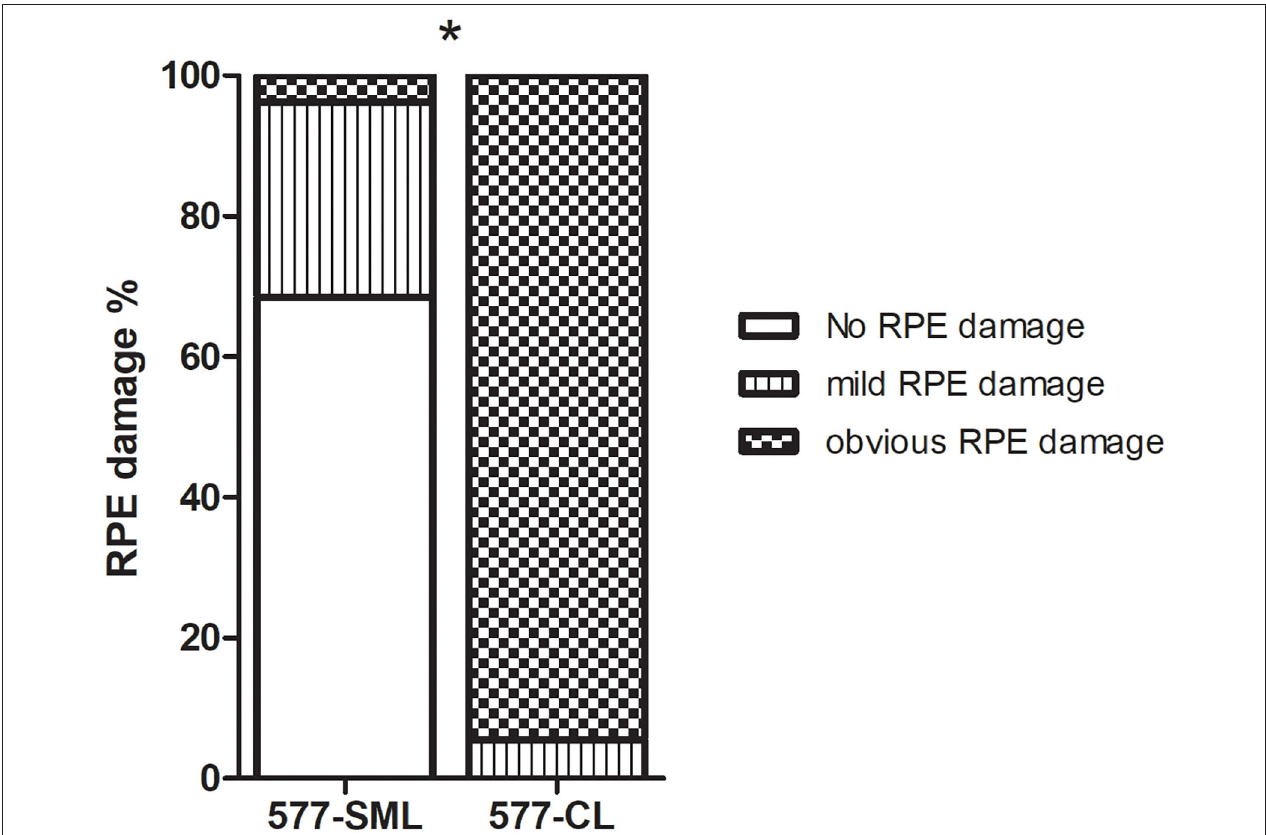
FIGURE 4 | The comparison of eyes with RPE change on FAF imaging at 1 month after treatments in the 577-nm SML group and 577-nm CL group. Error bars represent standard errors of the mean. SML, subthreshold micropulse laser. CL, conventional laser. RPE, retinal pigment epithelium. FAF, fundus autofluorescence. * P <